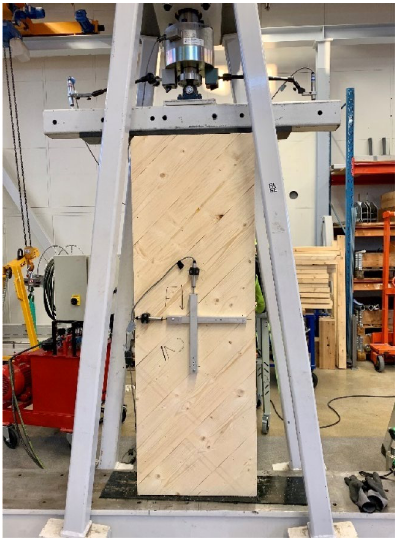
Fig. 3 Diaphragm shear test with attached displacement transduc- ers